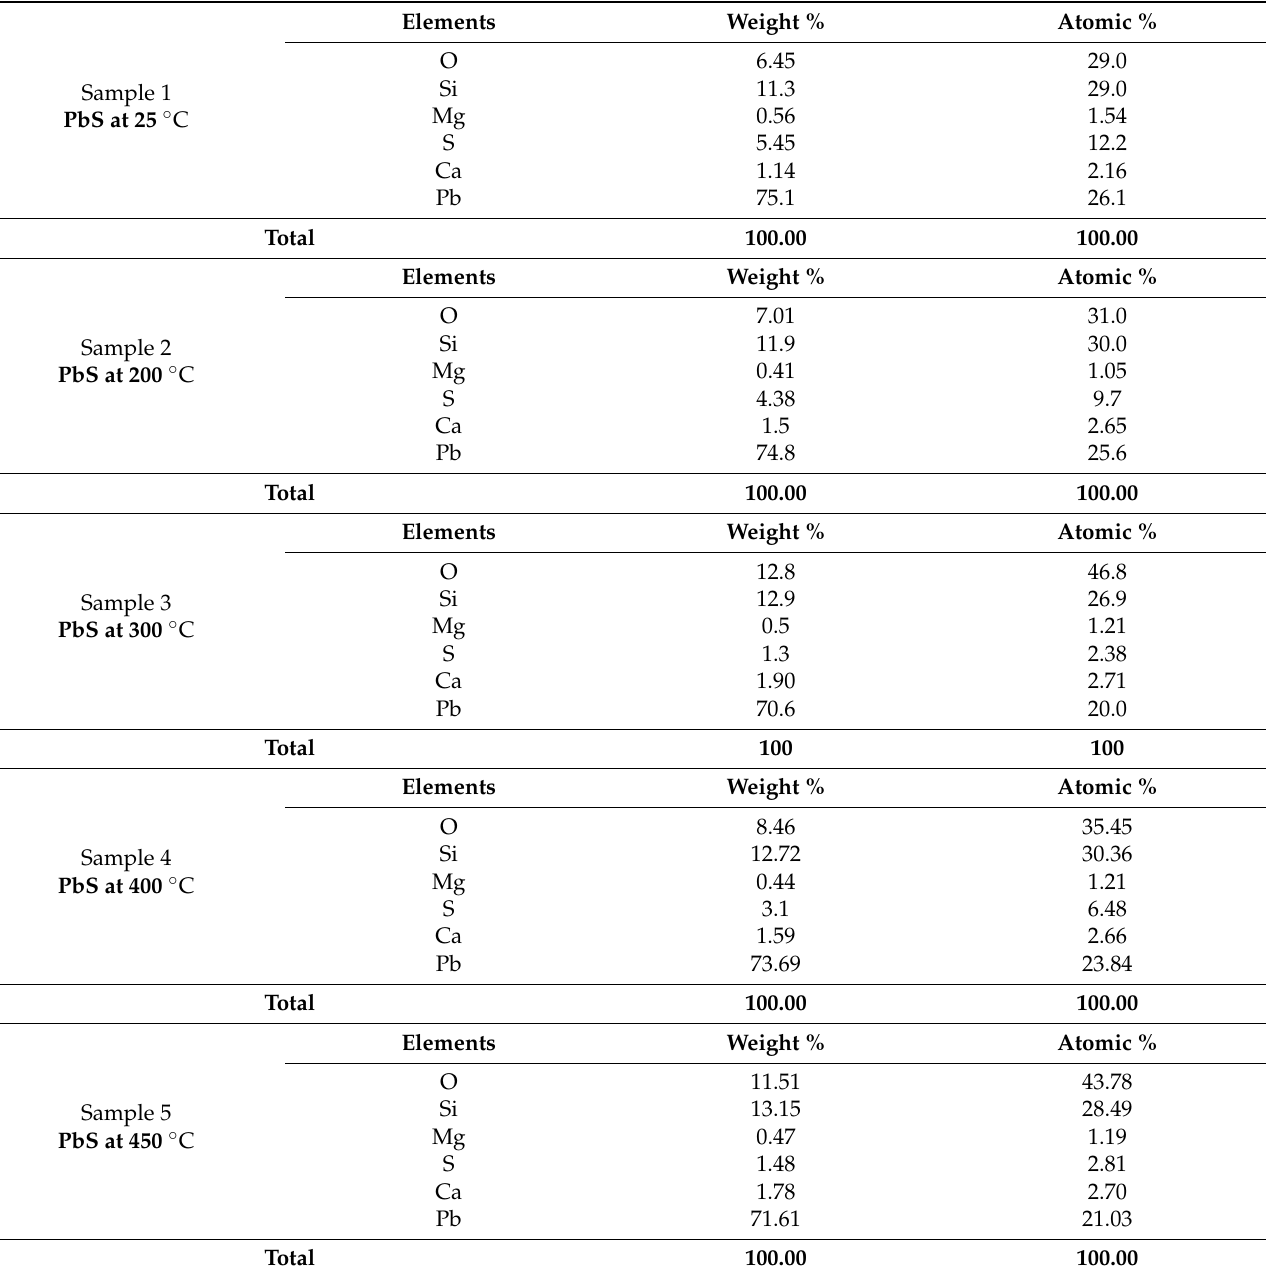
Table 1. Elemental concentrations determined by EDS of as-deposited PbS and annealed thin film at 200 ◦ C, 300 ◦ C, 400 ◦ C, and 450 ◦ C,